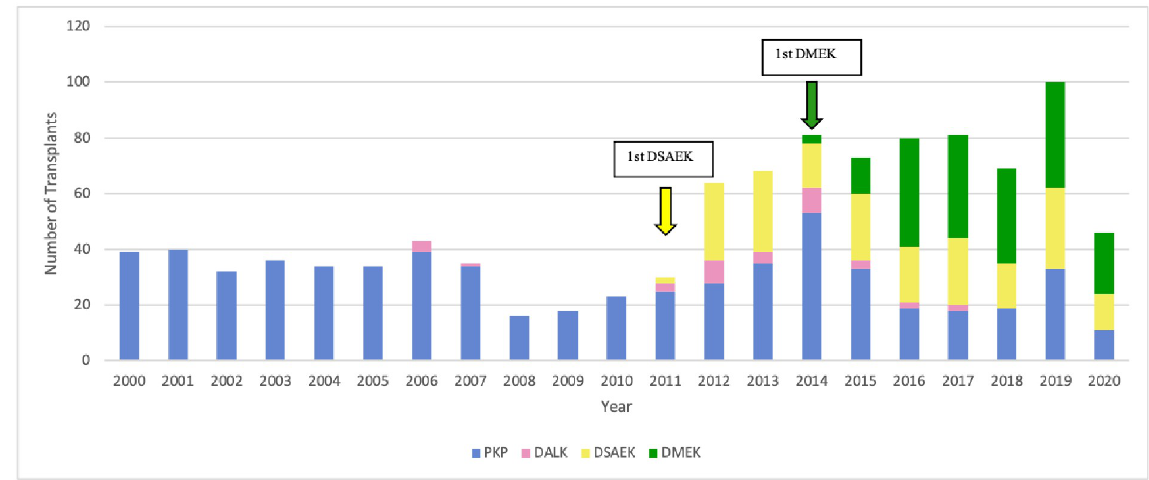
Fig 1. Changes in surgical techniques over time. DALK, deep anterior lamellar keratoplasty; DSAEK, Descemet stripping automated endothelial keratoplasty; DMEK, Descemet membrane endothelial keratoplasty; PKP, penetrating keratoplasty.